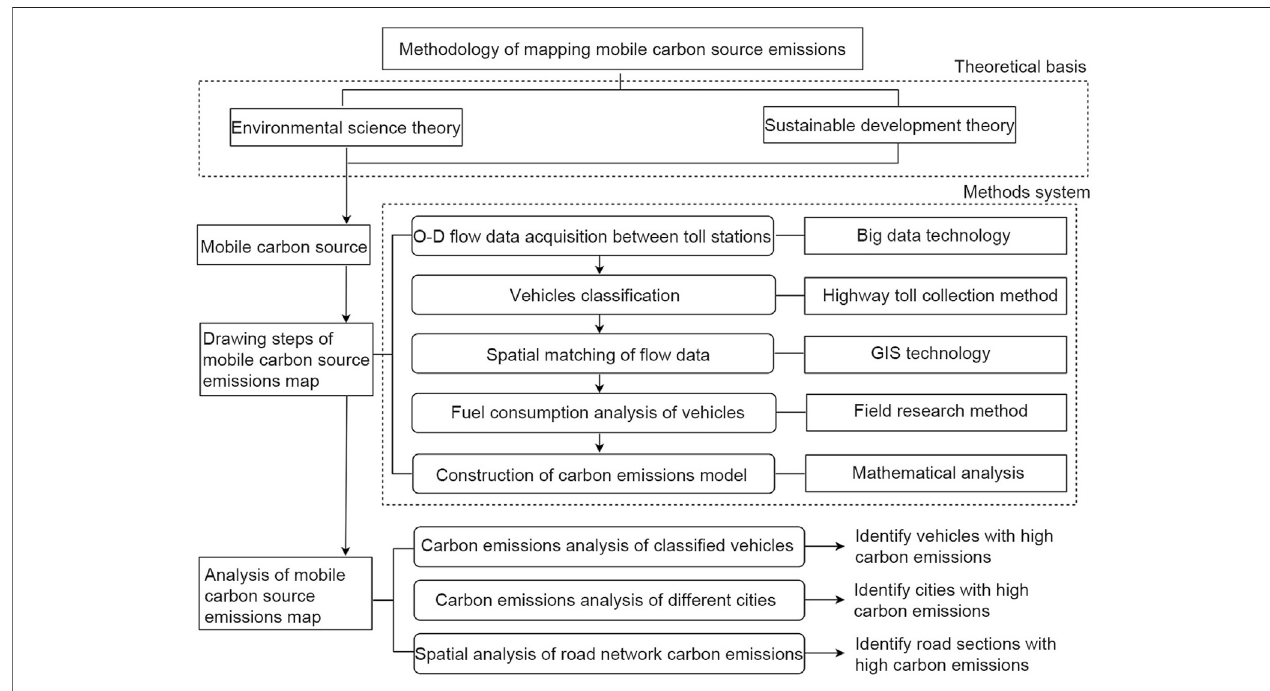
FIGURE 1 | Conceptual diagram of the methodology used for mapping and analyzing the mobile carbon source